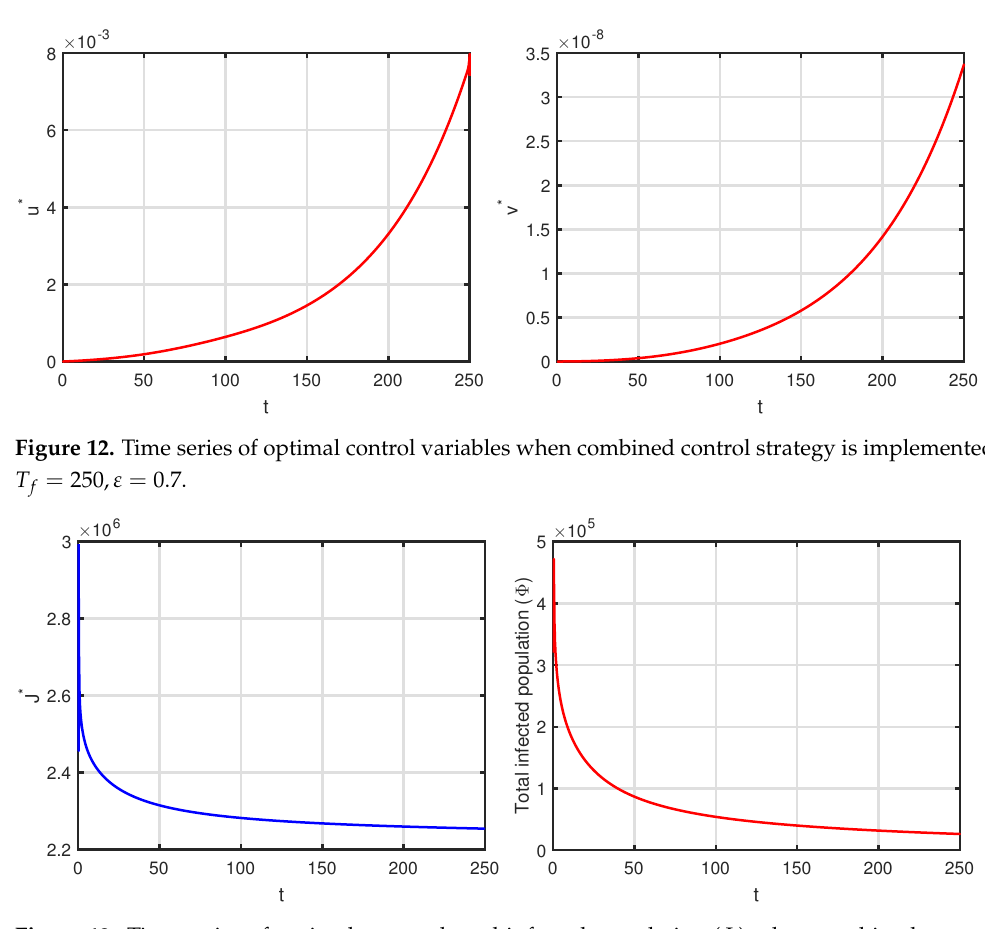
Figure 13. Time series of optimal cost and total infected population ( Φ ) when combined control strategy is implemented T f = 250, ε =